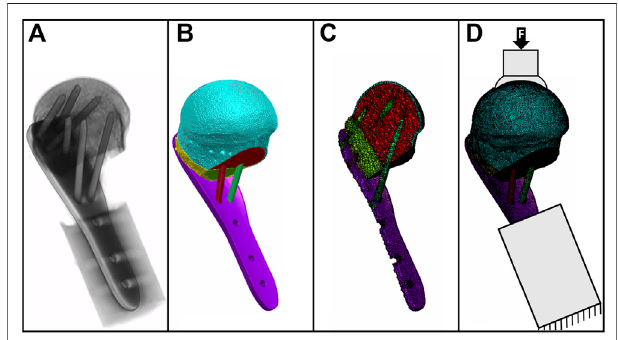
FIGURE 3 | Gray value image of a postoperative CT scan (A) with the underlyingmaskofbonefragmentsandimplants (B) ;thecross-sectionalview of the FE mesh (C) and the specimen-speci fi c FE model with boundary conditions are illustrated as fi xed at the distal part and with load applied on the bone surface (D)